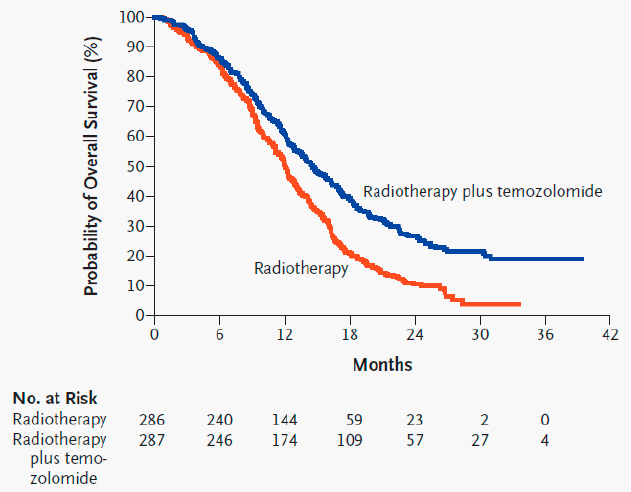
Figure 2. Kaplan–Meier estimates of overall survival of glioblastoma patients with radiotherapy alone compared to radiotherapy and temozolomide [5]. Used with permission. Table 2. Overall survival of glioblastoma patients with radiation therapy alone compared to radia- tion therapy plus temozolomide [5].